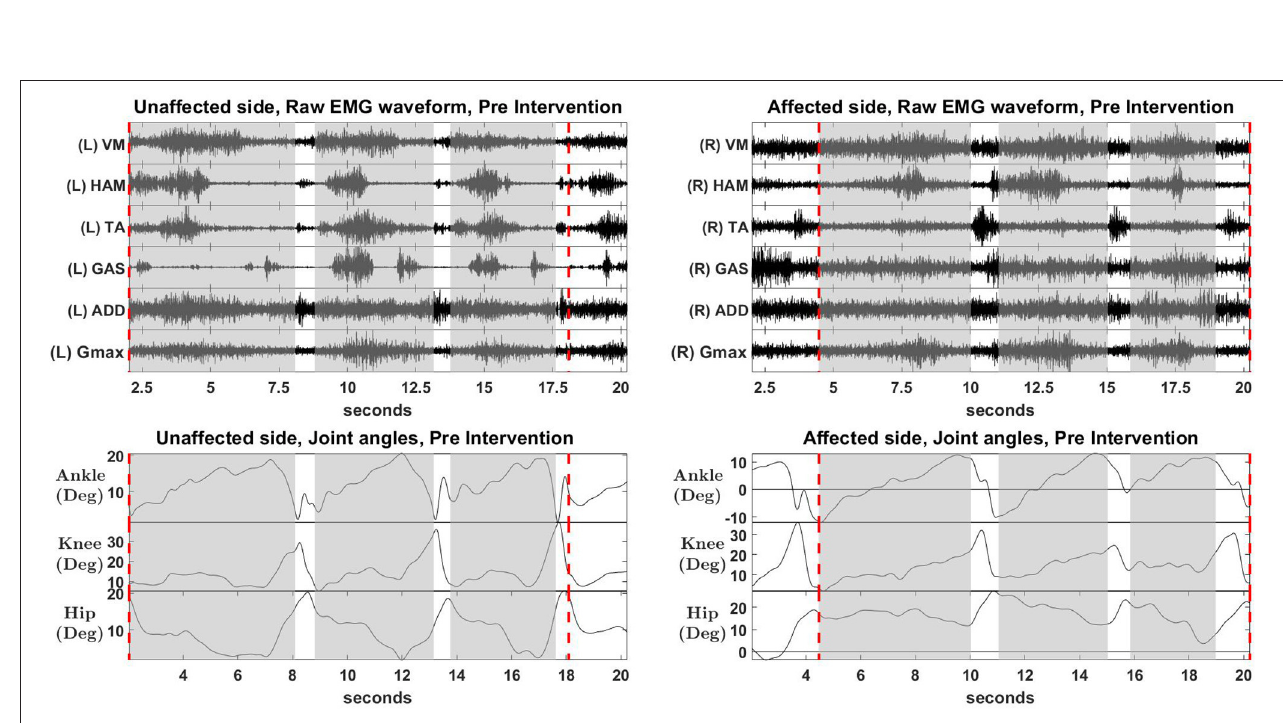
FIGURE 6 | Raw EMG waveform and joint angles, pre intervention. Positive values in angles indicate flexion, while negative values indicate extension.